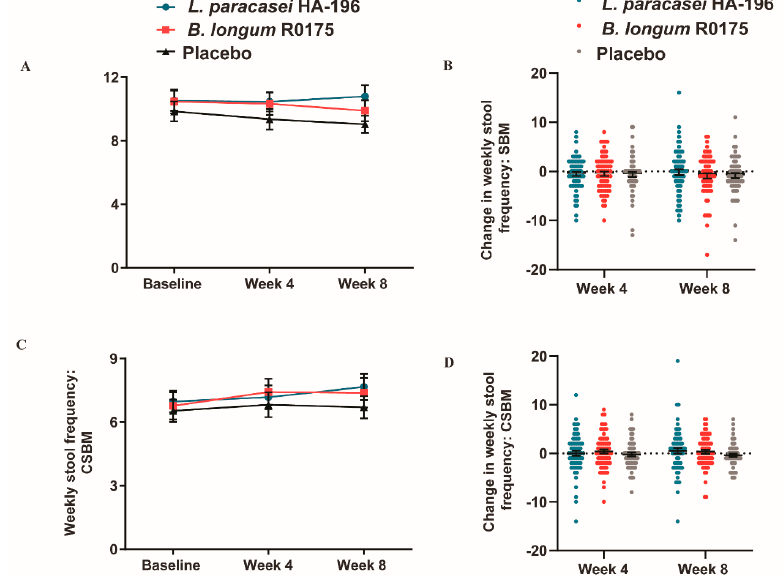
Figure 7. E ff ect of Lactobacillus paracasei HA-196 and Bifidobacterium longum R0175 on frequency of bowel movements in participants with IBS-M. ( A ) Weekly SBM at baseline, week 4 and week 8, ( B ) Change in total SBM from baseline to week 4 and week 8, ( C ) Total CSBM at baseline, week 4 and week 8, and ( D ) Change in weekly CSBM from baseline to week 4 and week 8. L. paracasei group n = 64, B. longum group n = 66, placebo group n = 55; data represented as mean ± SD; * p < 0.05, ** p < 0.01; SBM; spontaneous bowel movement; CSBM, complete spontaneous bowel movement; L. paracasei, Lactobacillus paracasei HA-196; B. longum , Bifidobacterium longum R0175.